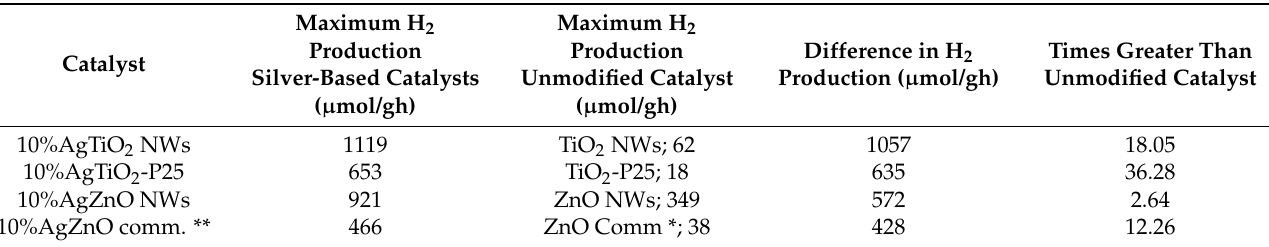
Table 4. Silver-based catalysts with the highest hydrogen production and their difference from the unmodified supports at a wavelength of 500 nm *.